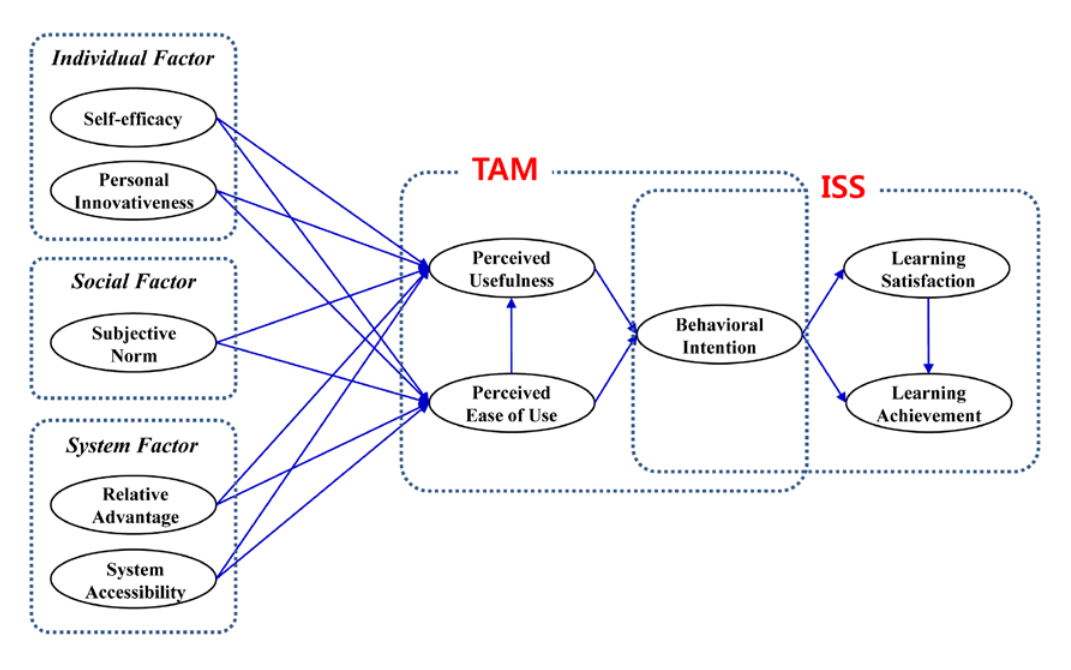
Figure 1. Research